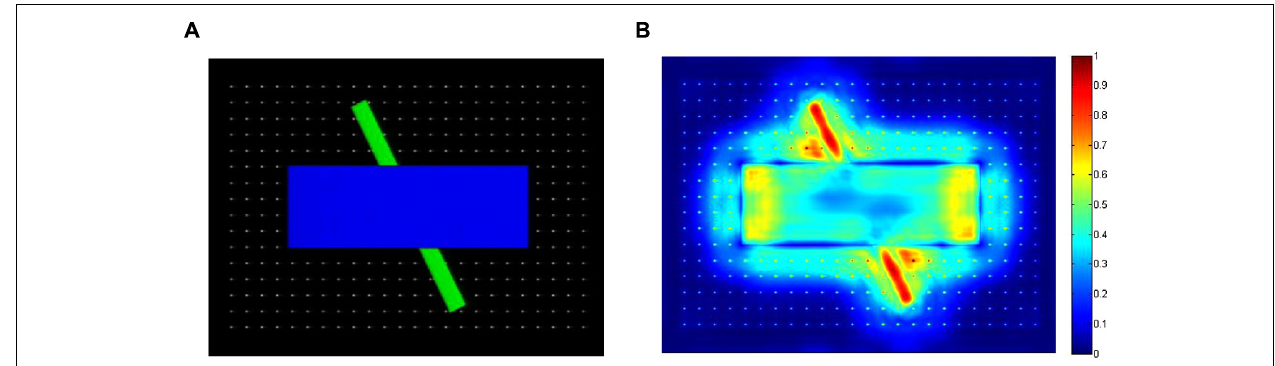
FIGURE 2 | Illustration of one of the still-frame images from the occluded-rod display (A), and the corresponding saliency map (B)